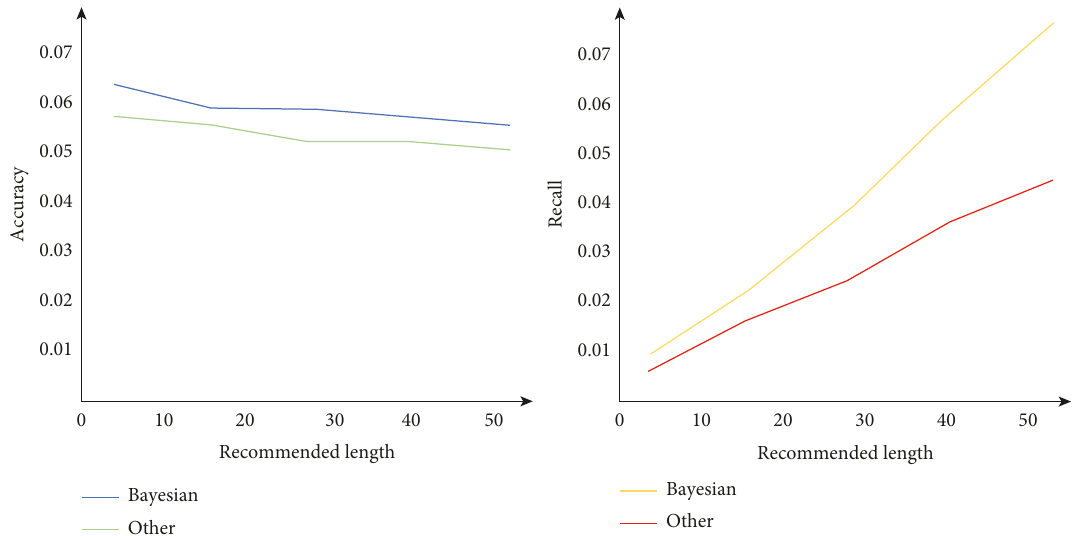
Figure 6: Comparison plot of precision and recall for two different algorithms.